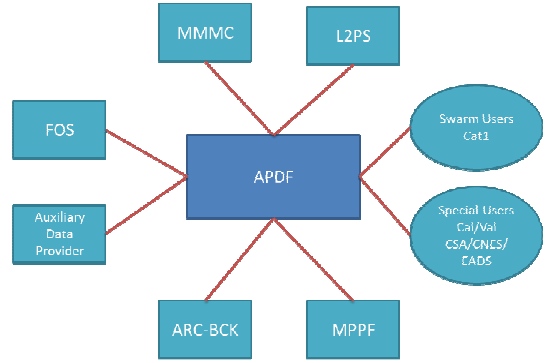
Figure 3: Swarm APDF External